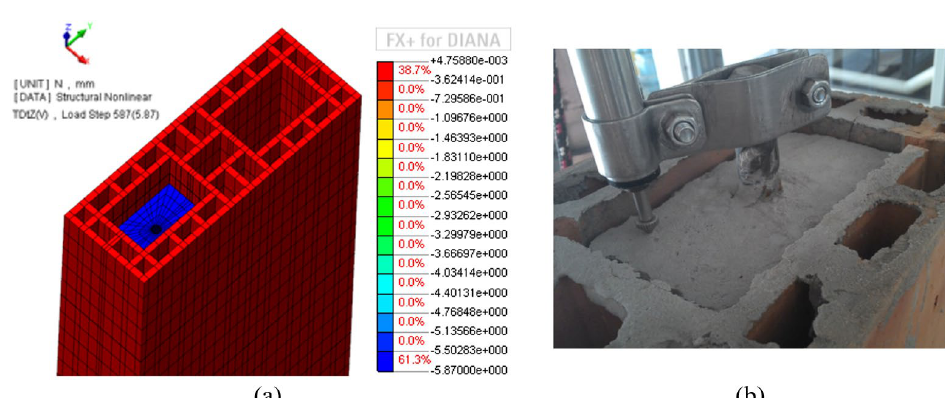
Figure 16. Displacement of the grout according to (a) the numerical model and (b) physical model of the ClG14S12 series.